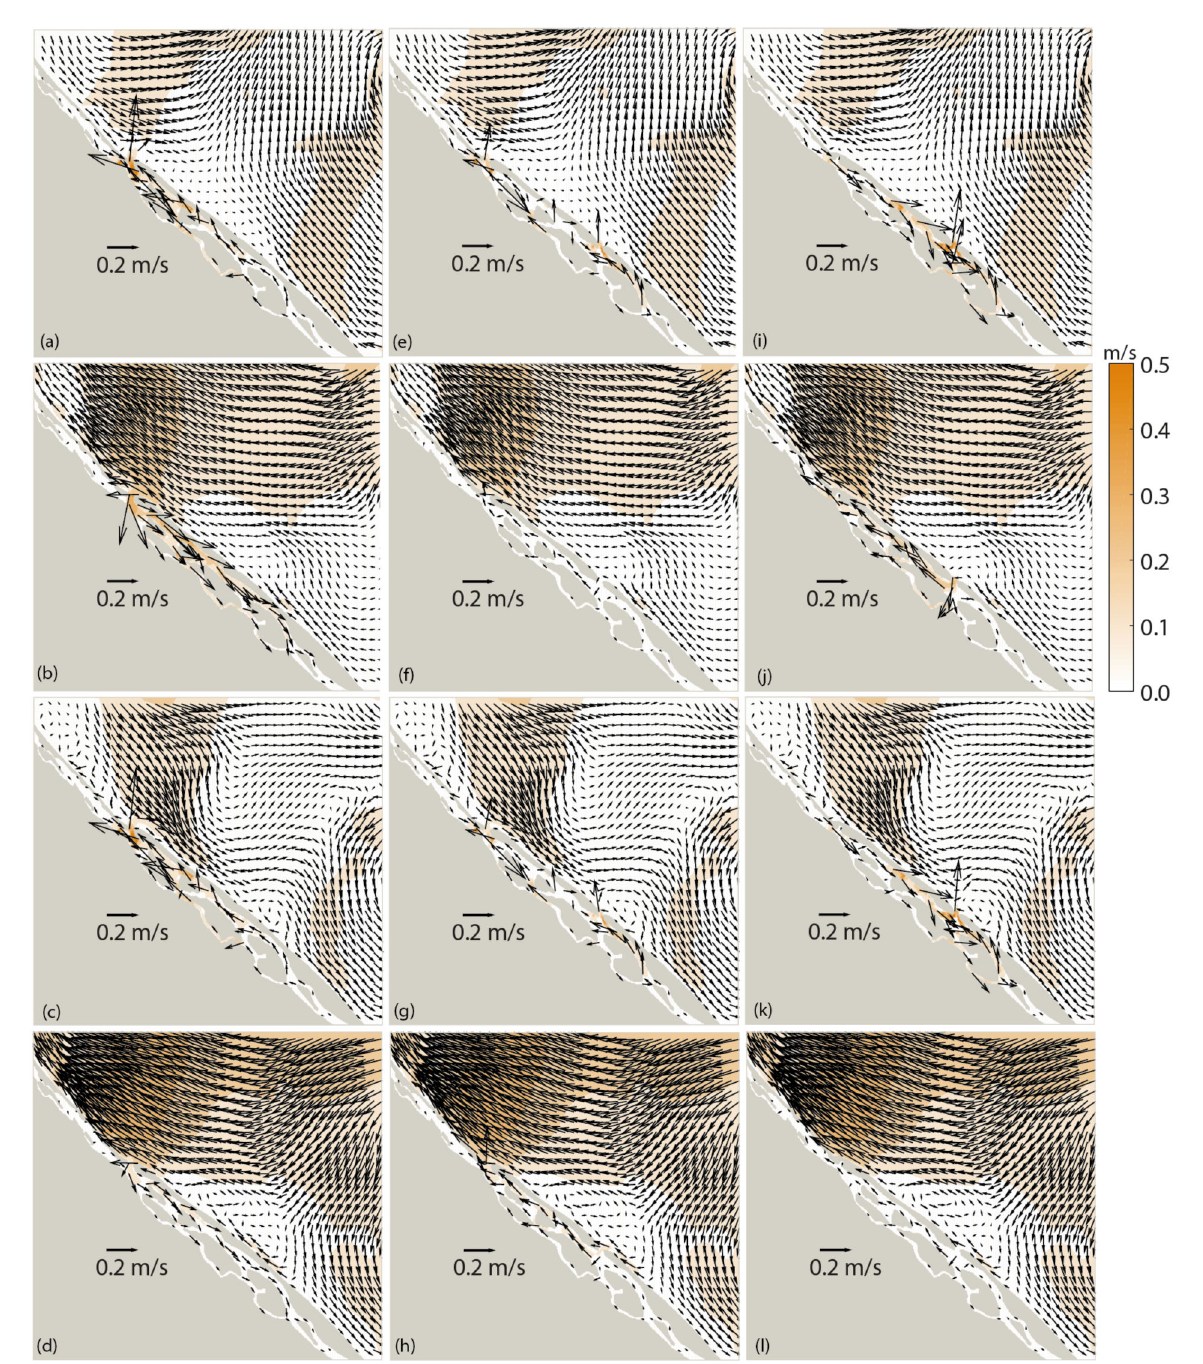
Figure 4. Distribution of water current in the Setiu Lagoon under old ( a – d ), both ( e – h ) and new ( i – l ) inlets configurations during the ebbing ( a + c , e + g , i + k ) and flooding ( b + d , f + h , j + l ) of the southwest (top two panels) and northeast (bottom two panels)